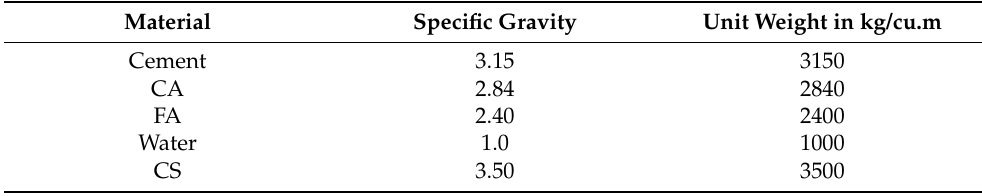
Table 1. Material specific gravities and unit weights.